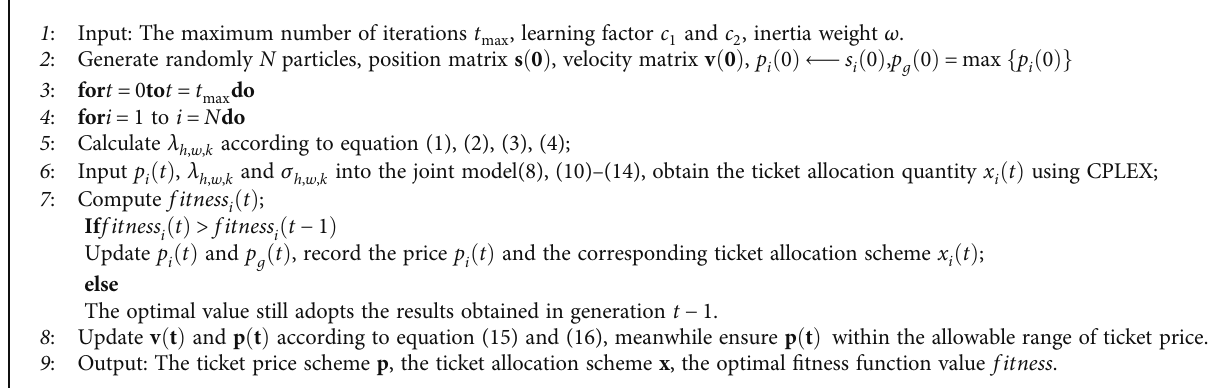
Algorithm 1: The algorithm steps.